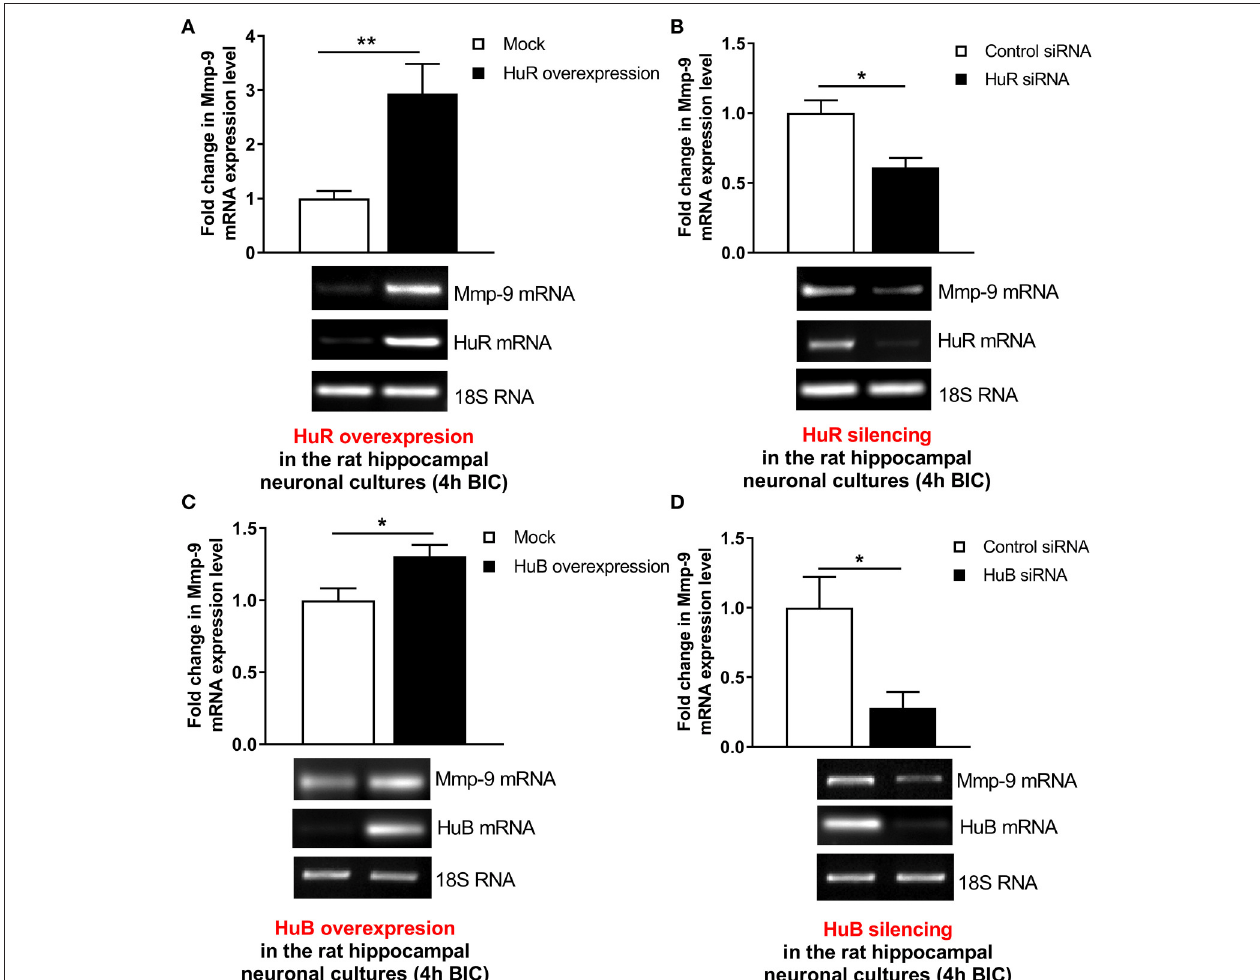
FIGURE 6 | HuR and HuB upregulate Mmp-9 mRNA expression in activated rat hippocampal neurons. (A) HuR overexpression increases Mmp-9 mRNA in bicuculline-treated rat hippocampal neuronal cultures. The cultures were transfected by the HuR overexpression construct HuR/pGW1 or the mock control vector pGW1 using the Neon Transfection System. On Day 7 in vitro (DIV 7), the cultures were treated with bicuculline. mRNA content was analyzed at 4h after neuronal activation by qRT-PCR. Mmp-9 expression was normalized against 18S rRNA expression. Data are presented as fold change in mRNA expression. Two-tailed Student’s t -test. Values are mean ± SEM (** p < 0.01; n = 5). (B) HuR silencing downregulates Mmp-9 mRNA in bicuculline-treated rat hippocampal neuronal cultures. The cultures were transfected by HuR siRNA or control siRNA using the Neon Transfection System. On Day 7 in vitro (DIV 7), the cultures were treated with bicuculline. mRNA content was analyzed 4h after neuronal activation by qRT-PCR. Mmp-9 expression was normalized against 18S rRNA expression. Data are presented as fold change in mRNA expression. Mann–Whitney U -test. Values are mean ± SEM (* p < 0.05; n = 5). (C) HuB overexpression increases Mmp-9 mRNA in bicuculline-treated rat hippocampal neuronal cultures. The cultures were transfected by the HuB overexpression construct HuB/pGW1 or mock control vector pGW1 using the Neon Transfection System. On Day 7 in vitro (DIV 7), the cultures were treated with bicuculline. mRNA content was analyzed 4h after neuronal activation by qRT-PCR. Mmp − 9 expression was normalized against 18S rRNA expression. Data are presented as fold change in mRNA expression. Two-tailed Student’s t -test. Values are mean ± SEM (* p < 0.05; n = 5). (D) HuB silencing downregulates Mmp-9 mRNA in bicuculline-treated rat hippocampal neuronal cultures. The cultures were transfected by the HuB silencing construct HuB/pSuper or mock control vector pSuper using the Neon Transfection System. On Day 7 in vitro (DIV 7), the cultures were treated with bicuculline. mRNA content was analyzed 4h after neuronal activation by qRT-PCR. Mmp-9 expression was normalized against